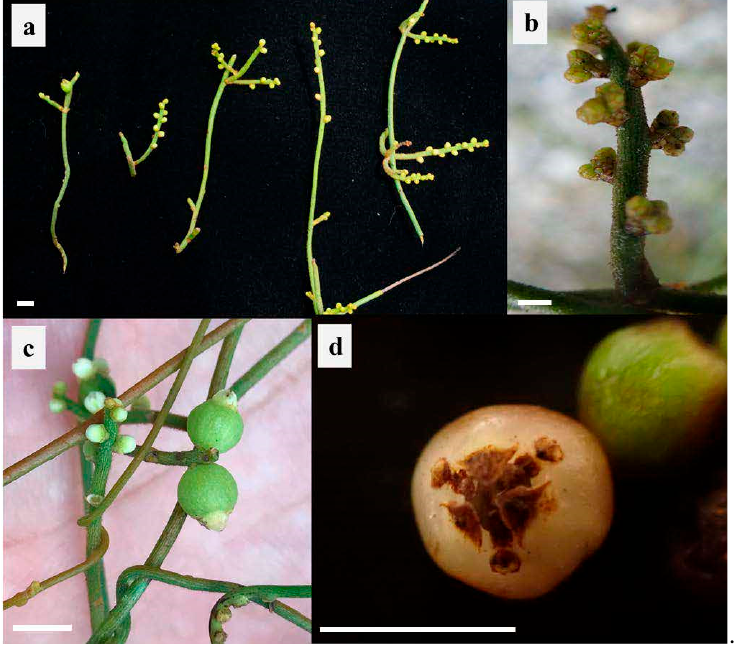
Figure 1. Representative inflorescence and fruits of Cassytha filiformis . ( a ) Inflorescence collected in Guangzhou (Guangdong, longitude: 113 ◦ 17 (cid:48) E, latitude: 23 ◦ 0 (cid:48) N, altitude: 10 m). ( b ) Inflorescence collected in Xishuangbanna (Yunnan, longitude: 100 ◦ 45 (cid:48) E, latitude: 22 ◦ 28 (cid:48) N, altitude: 1129 m). ( c ) Inflorescence and unripe fruits collected in Lingshui (Hainan, longitude: 109 ◦ 54 (cid:48) E, latitude: 18 ◦ 34 (cid:48) N, altitude: 76 m). ( d ) Ripe fruit collected in Guangzhou (Guangdong, longitude: 113 ◦ 17 (cid:48) E, latitude: 23 ◦ 0 (cid:48) N, altitude: 10 m). Scale bars = 5